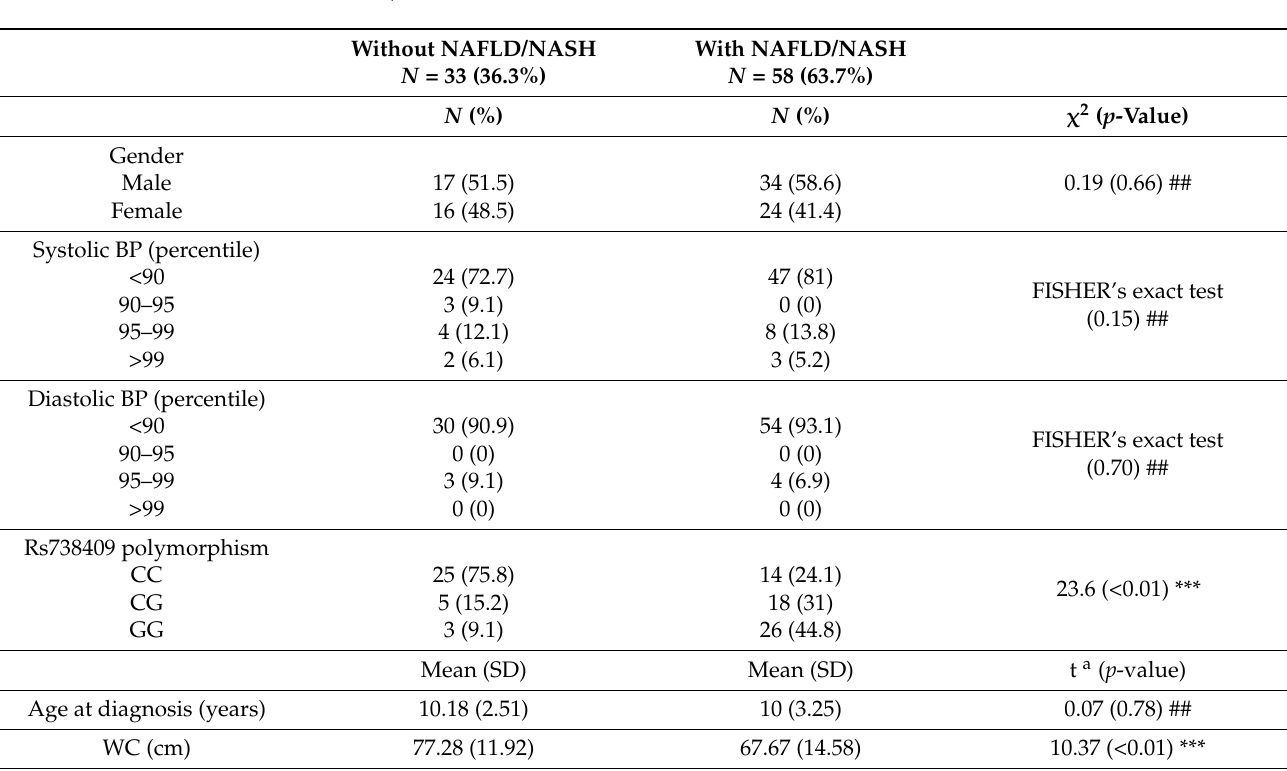
Table 4. Demographic, basic clinical, and laboratory characteristics in children with and without